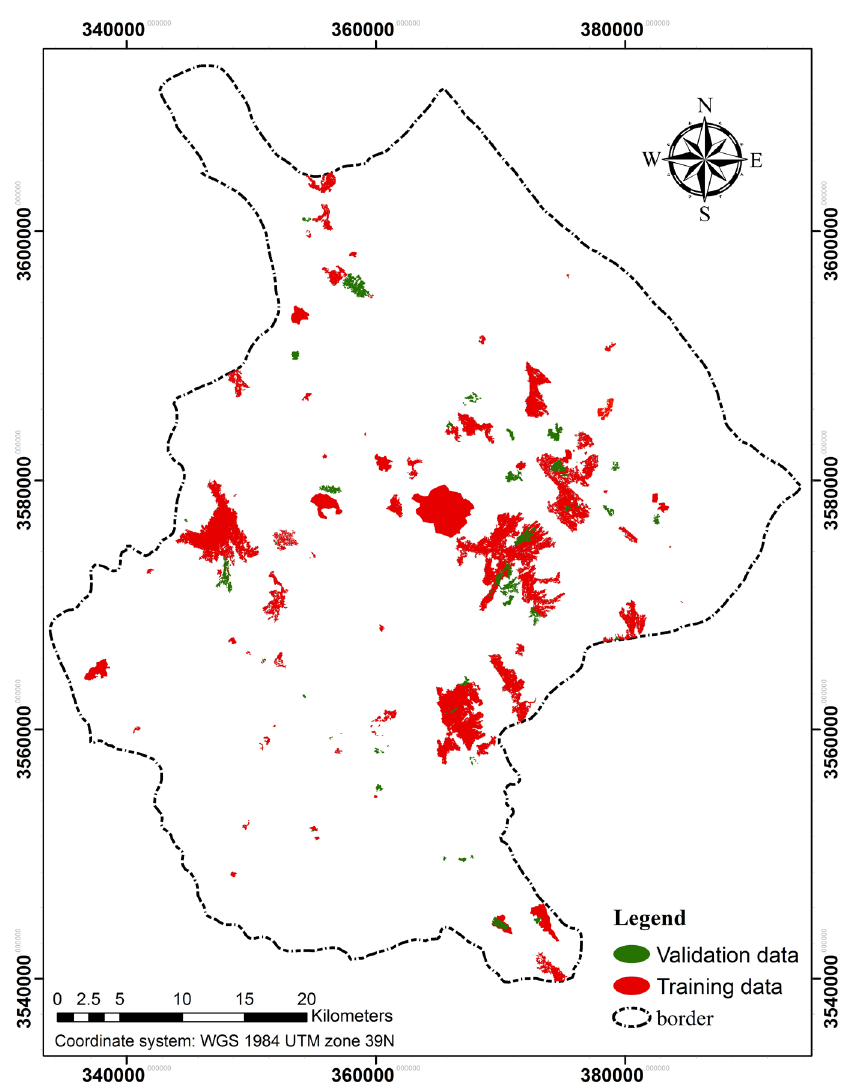
Figure 6. Map of historical fires resulting from the NBR index for the study area